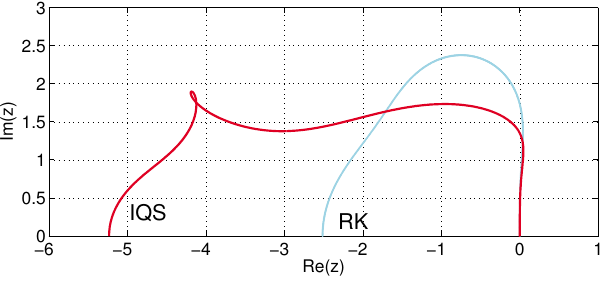
Figure 2. Stability regions of RK method of order p = 3 and GLMs with p = s = r = 3, q = 2 with IQS.